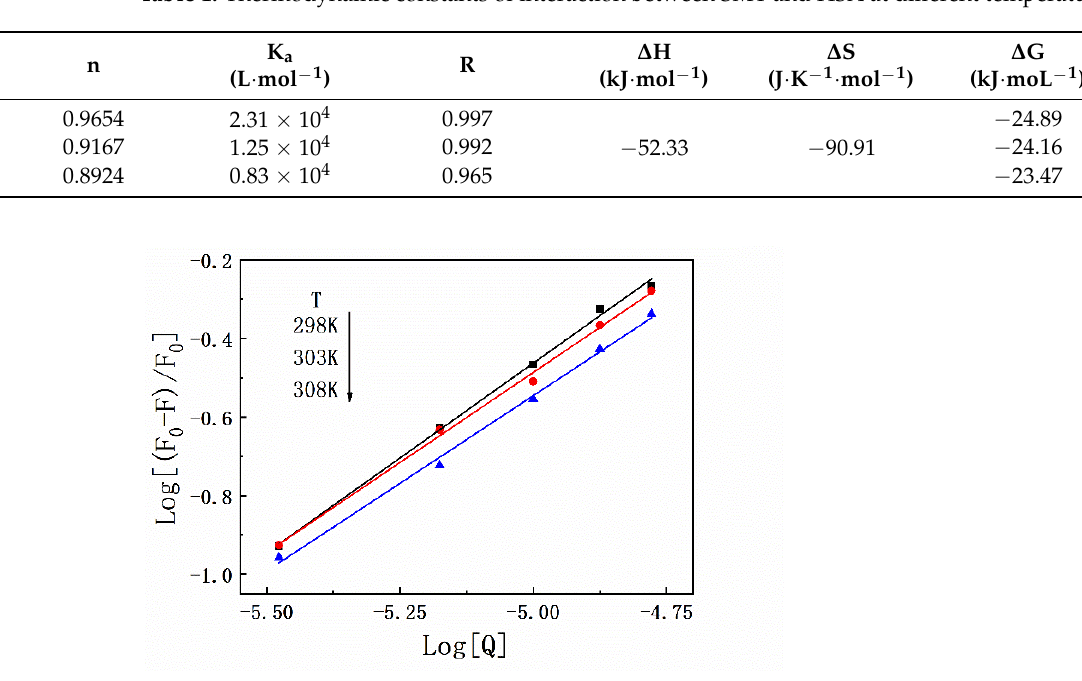
Figure 2. ( a ) Fluorescence decay curve of HSA in the absence and presence of SMT. C HSA = C SMT = 3.3 × 10 −6 mol·L −1 . ( b ) Fluorescence intensity corresponding to different SMT concentrations.